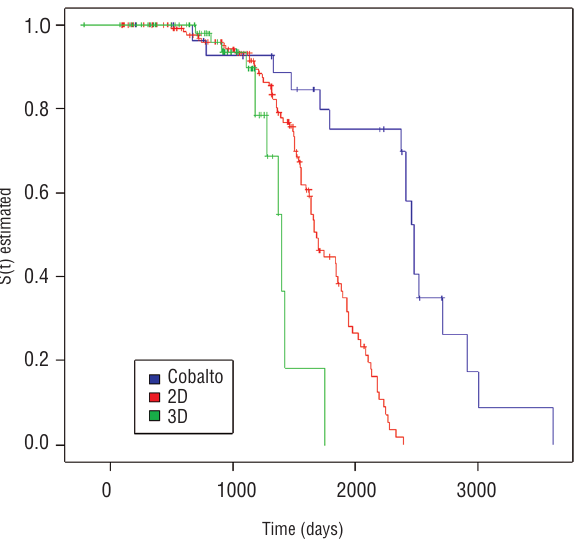
Figure 4 - Disease-free survival curves (Kaplan-Meier estimates) for Rtco, RT2D and RT3D treatments.